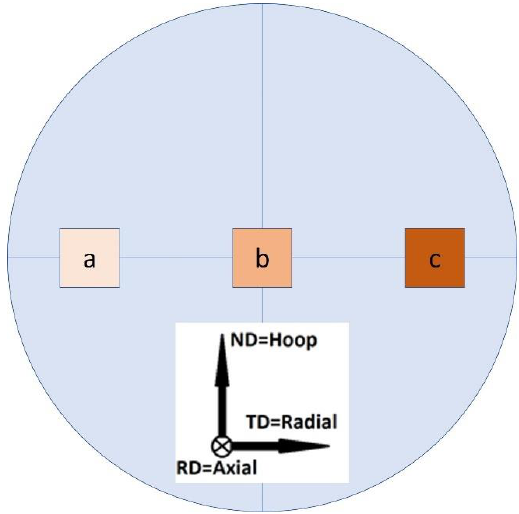
Figure 3. Scheme of the investigated regions with the Electron back-scatter diffraction (EBSD) method.